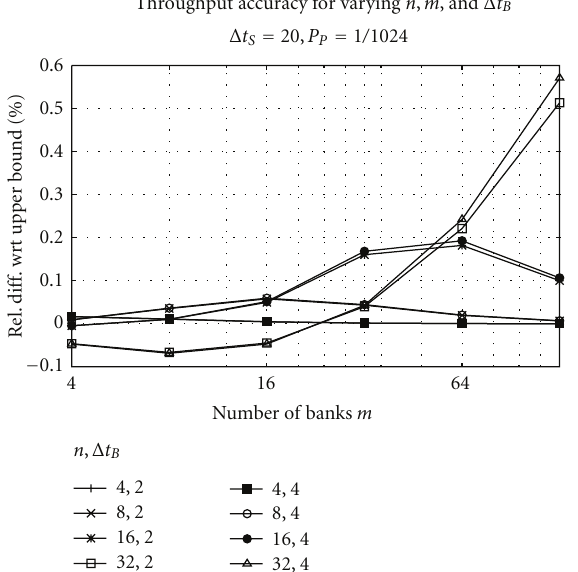
Figure 5: Accuracy of the approximation for n H ≥ 2.